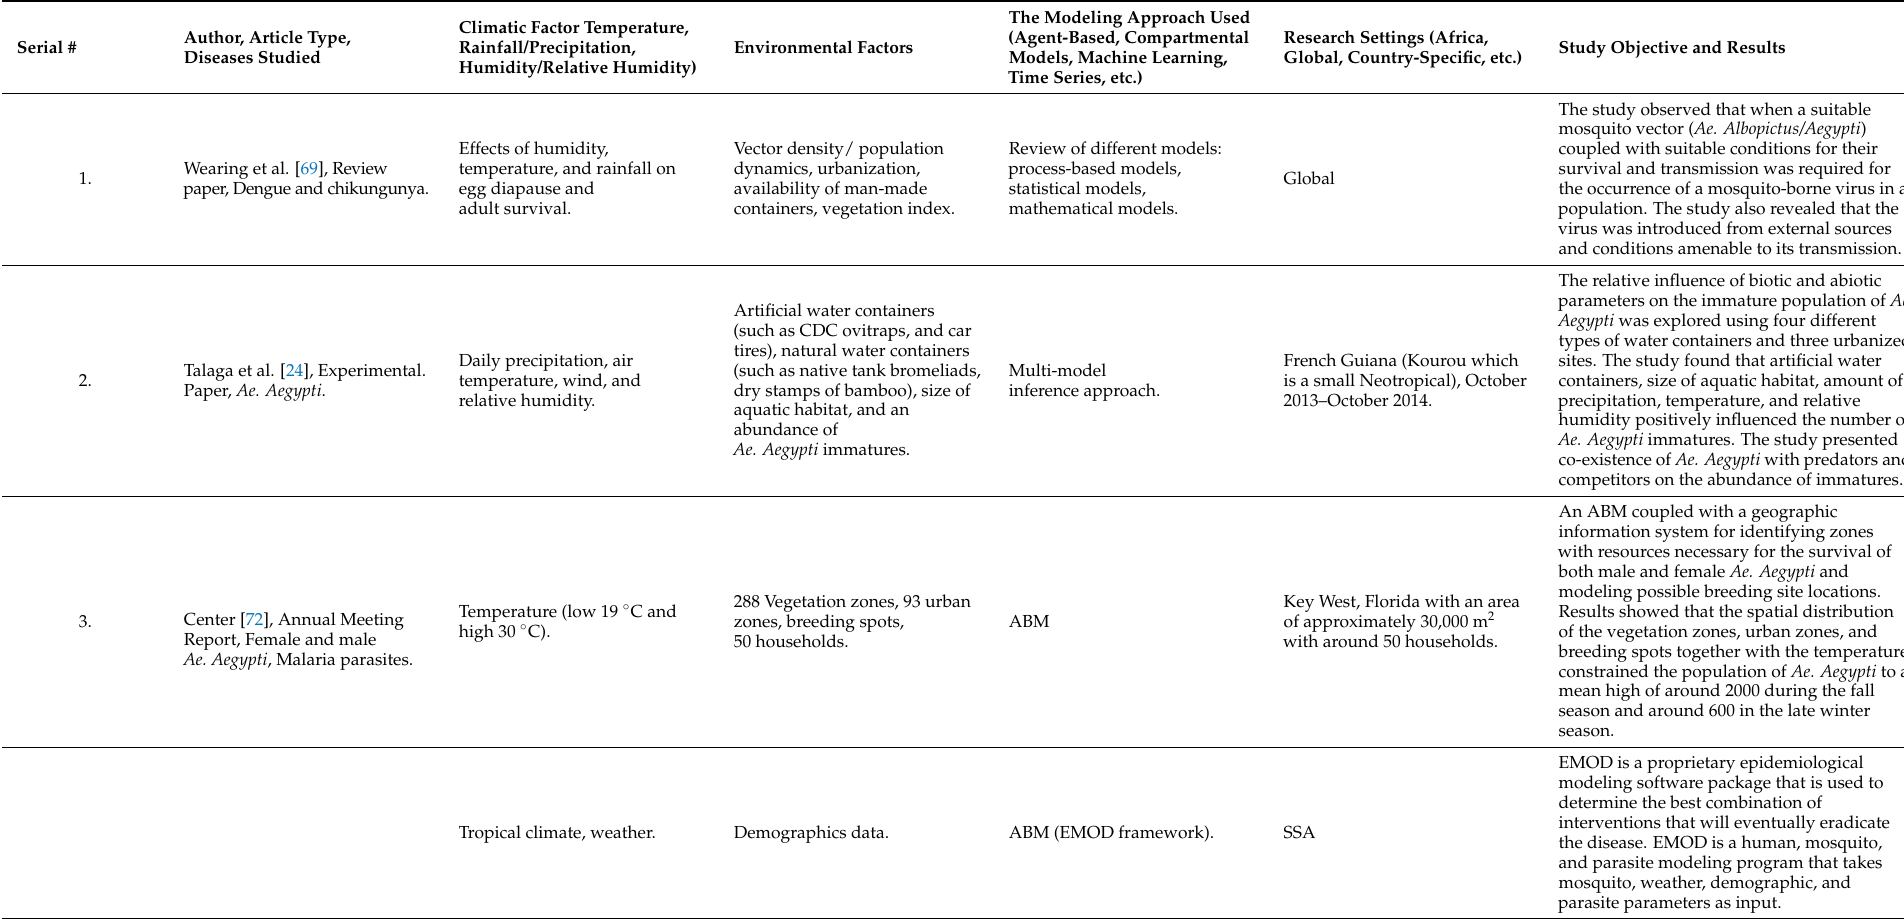
Table A1. Summary of reviewed